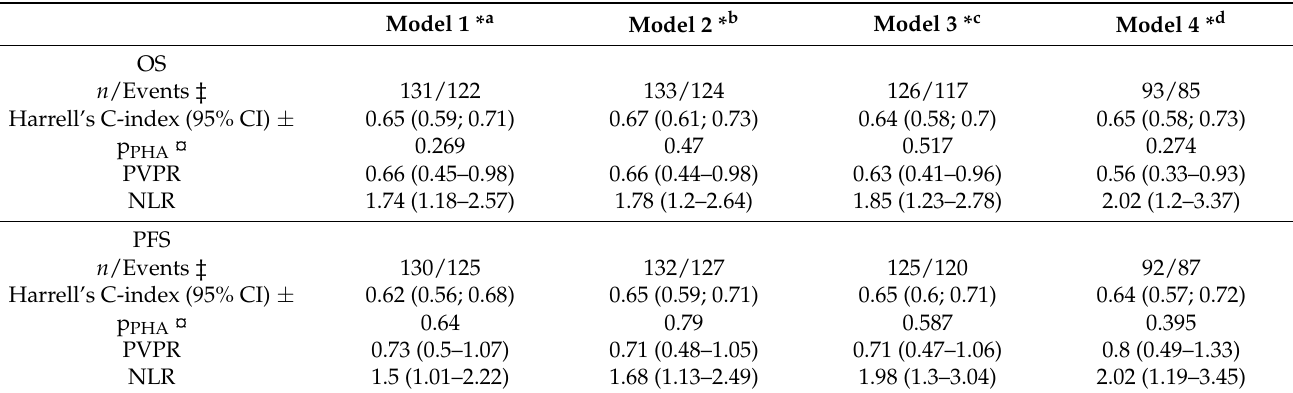
Table 3. Multivariable Cox regression analysis.